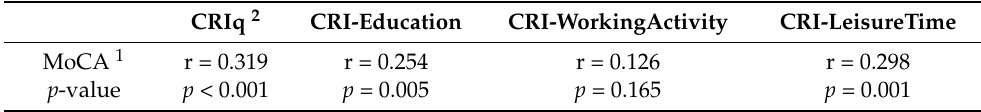
Table 5. Semi-partial correlation between CRIq and MoCA score adjusting for sex, age and depression.